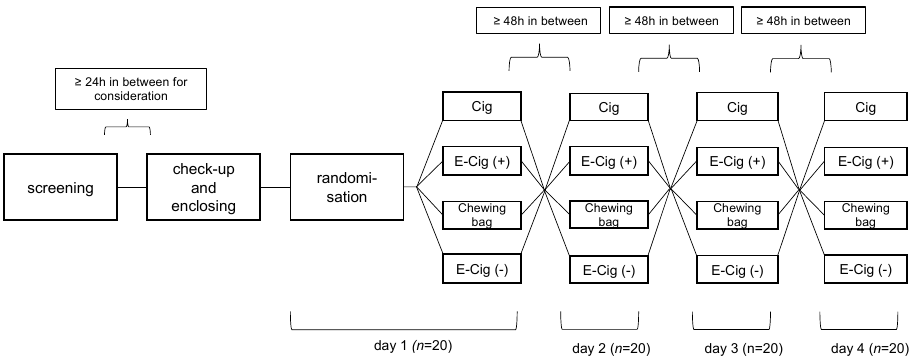
Figure 1. Flowchart and study design. After screening and enclosing the randomization decided the order of the four different test devices. Each device is only used once. In between the test days a washout period of at least 48 h had to be completed.